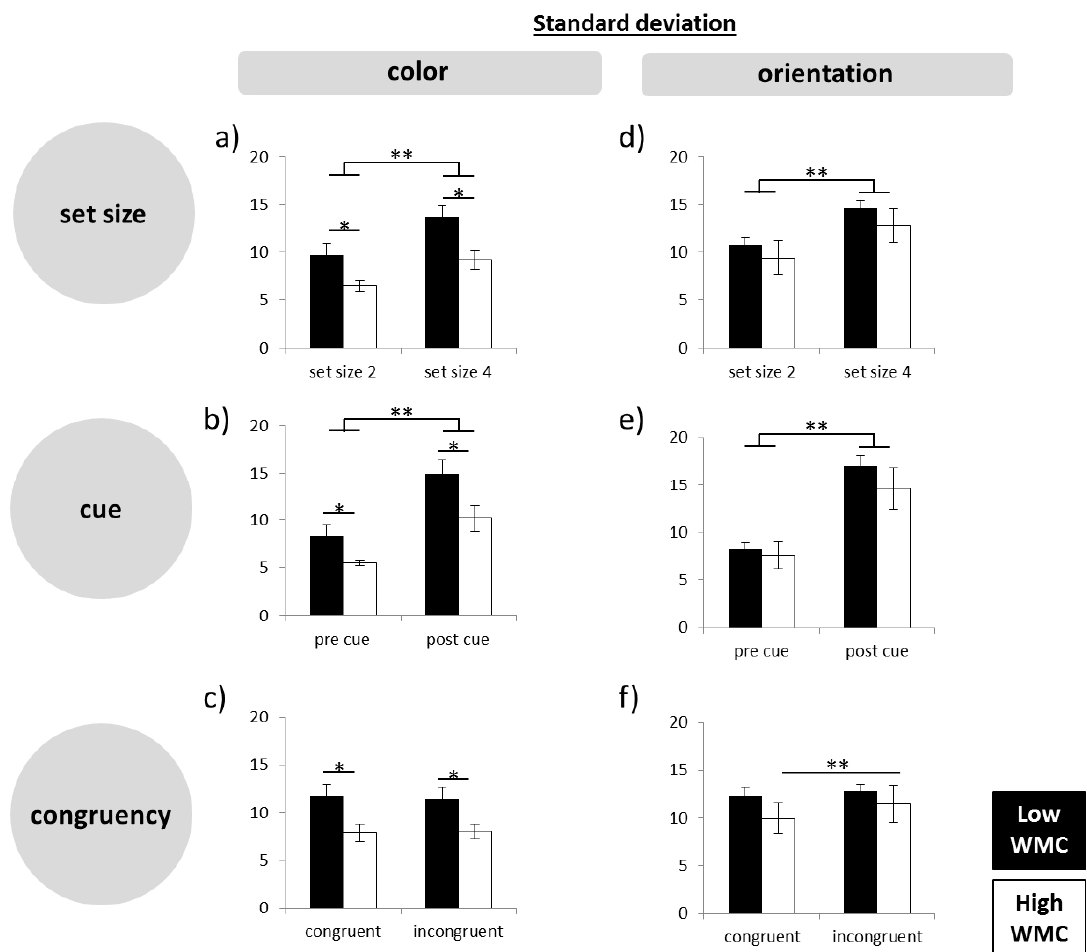
Figure 2. Standard deviations from the precision task for color and orientation separated for each task condition (set size, cue, congruency). The three manipulations of task difficulty led to more imprecise responses. WMC, working memory capacity. ∗ = p ≤ 0.05; ∗∗ = p ≤ 0.01.